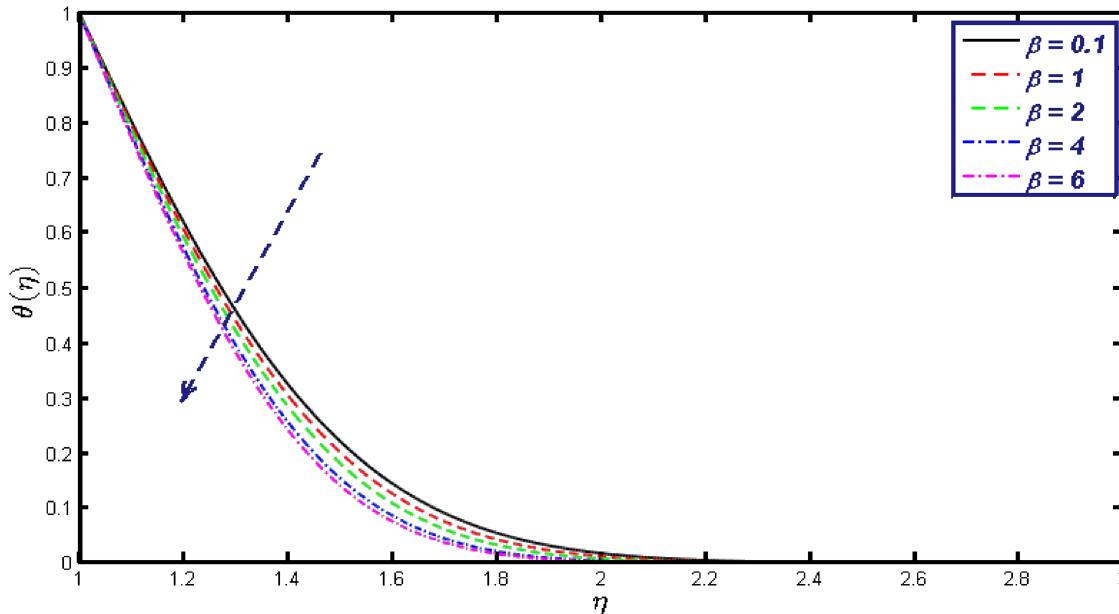
Figure 9. Temperature field for different values of β .